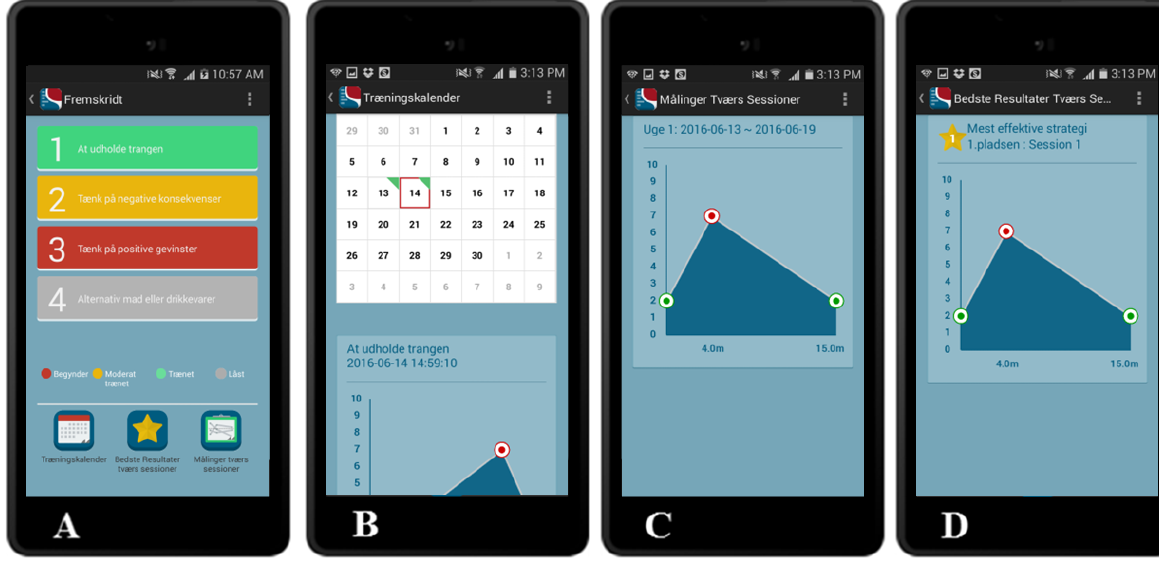
Monitoring Use and